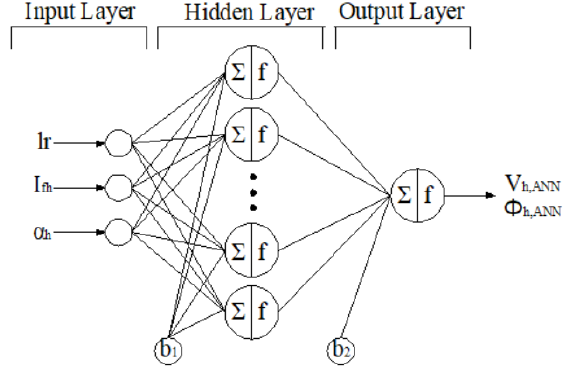
Figure 7. Structure of the used ANN.